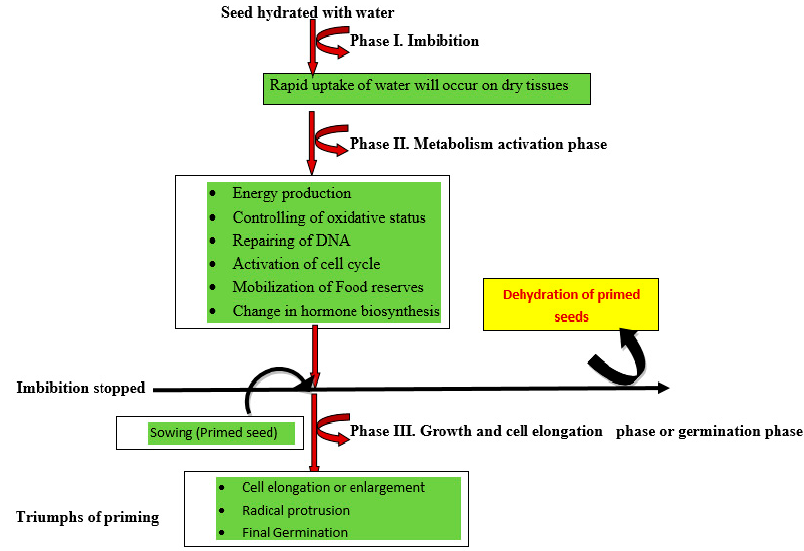
Figure 2. Thematic flow chart of sequence of events upon seed priming.